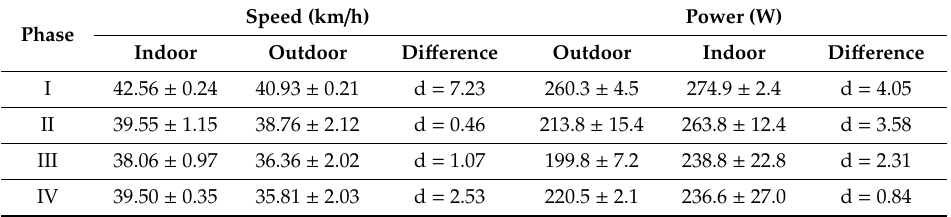
Table 1. Comparison between indoor and outdoor performances by phase of the race. d = (Cohen’s d )